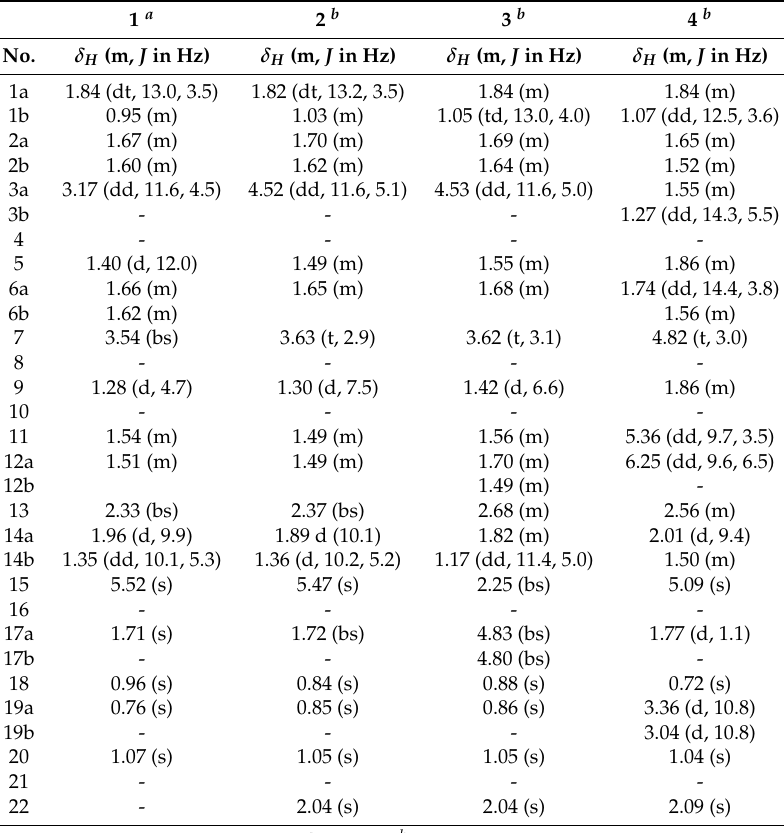
Table 1. 1 H NMR data of compounds 1 – 4 ( 1 H 500 MHz).